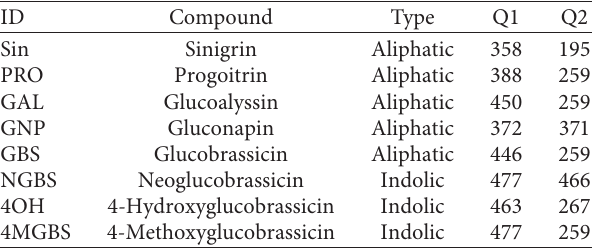
Table 3: Details of glucosinolates quantified in of Chinese flow- ering